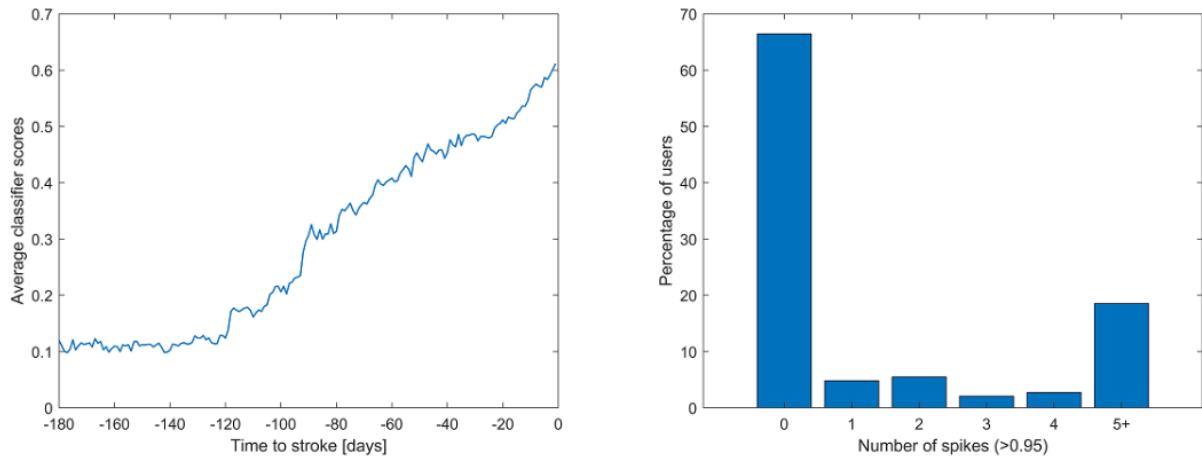
Figure 5. Average classifier scores as a function of the time to estimated stroke date (left) and the number of times that each user had classifier scores greater than 0.95 (right) in the period between 120 days prior to the estimated stroke date and the day